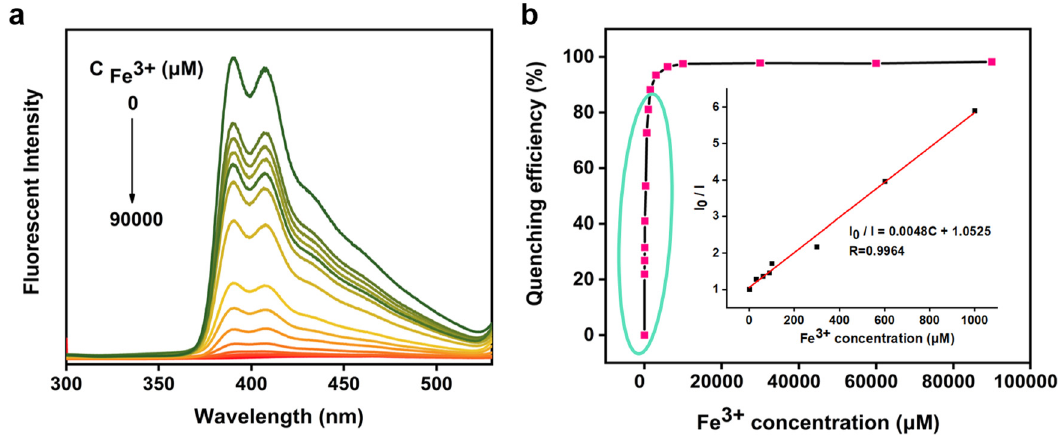
Figure 4: Linear range and the LOD of CNC - 1 - Pyr solution for quantitative detection of Fe 3 + : ( a ) fl uorescence emission spectra of CNC - 1 - Pyr solution mixing with Fe 3 + solution and ( b ) calculated quenching e ffi ciency of CNC - 1 - Pyr solution, the inset is Stern – Volmer plot of the quenching behavior.